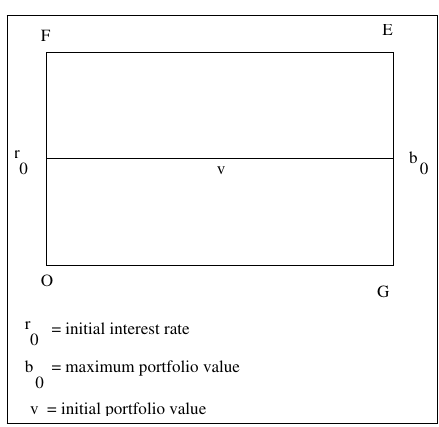
Figure 4. Optimization at time